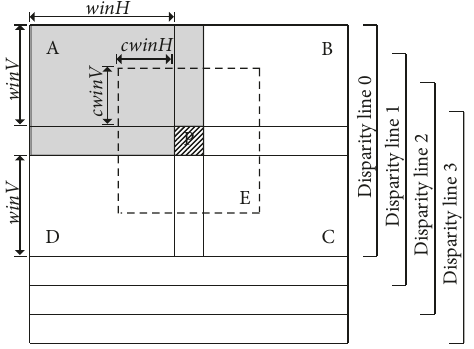
Figure 3: Enlarging the strip height to calculate 4 disparity